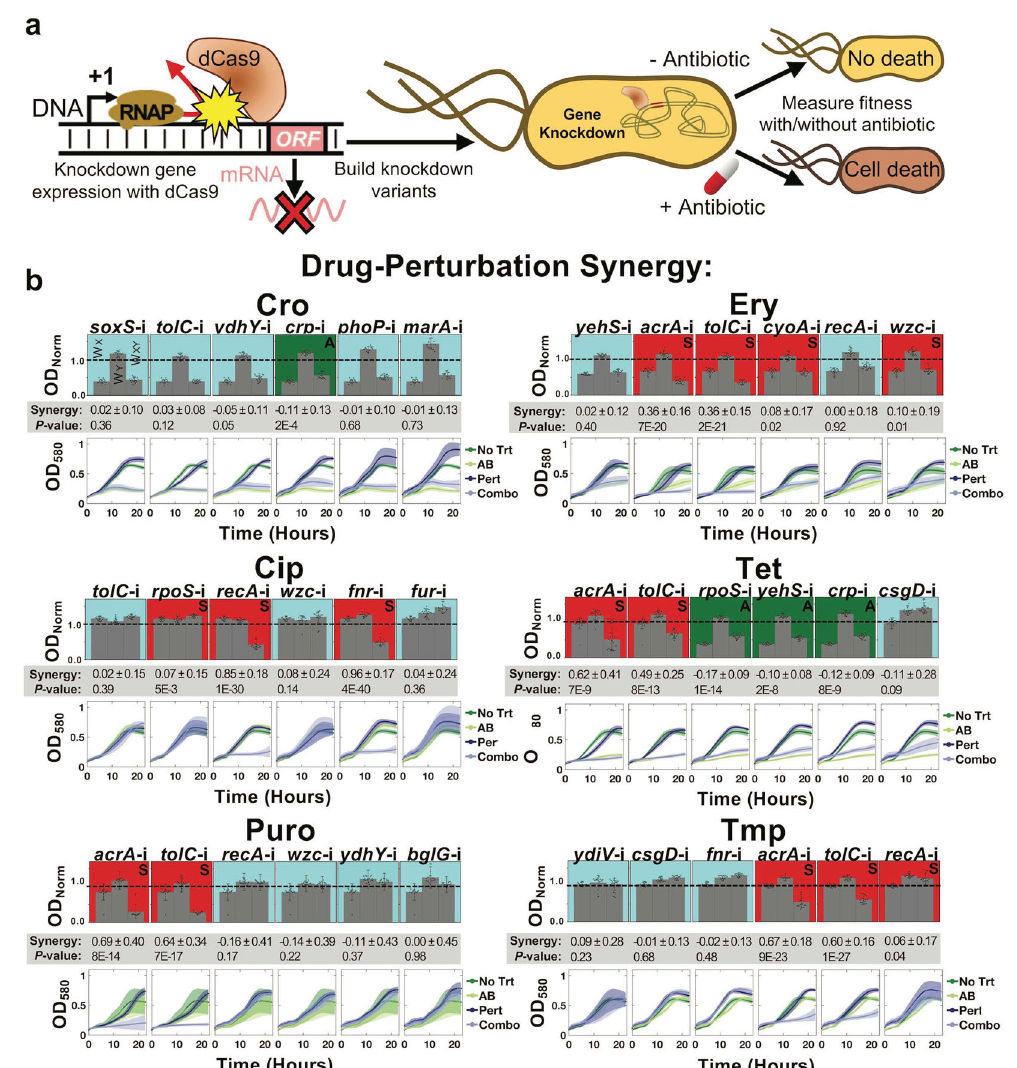
Fig. 3 Applying CRISPRi to potentiate antibiotic treatment. a dCas9 is targeted to promoter or open reading frame elements of speci fi c genes, preventing RNA polymerase from transcribing DNA into mRNA. Constructs were created to block transcription of six genes for which deletion resulted in signi fi cant synergy with a speci fi c antibiotic. b Each of these CRISPRi strains were tested for their synergy with antibiotic treatment. Strain ODs ’ after 16 h of growth in M9 minimal media were quanti fi ed and these values were used to calculate fi tness. The growth of the control rfp perturbation strain during exposure to the listed antibiotic, the growth of the gene perturbation with no antibiotic, and the growth of the gene perturbation in the presence of the listed antibiotic were all normalized to the growth of the control strain without exposure to antibiotic, giving W X , W Y , and W XY respectively. Statistically signi fi cant synergy or antagonism is indicated by a red background and an “ S ” or green background and an “ A ” respectively, with additive interactions shown in blue. Synergy values are listed below each graph with their associated signi fi cance. Error bars represent standard deviation of at least 20 biological replicates. Growth curves of each associated bar graph are shown below. Dark green lines indicate the control, light green lines indicate antibiotic only exposure, dark blue lines indicate CRISPRi perturbation (Pert in legend), and light blue lines indicate combination. Error bars represent standard deviation of at least 20 biological replicates and gray circles represent individual biological